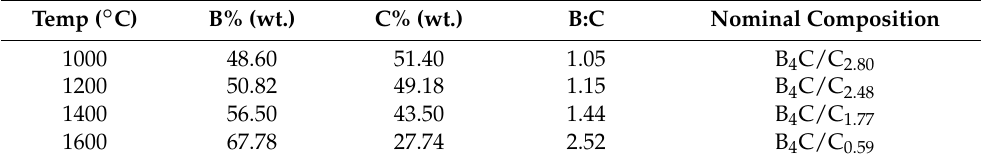
Table 2. The bulk pyrolyses results of the P(ND- co -D)